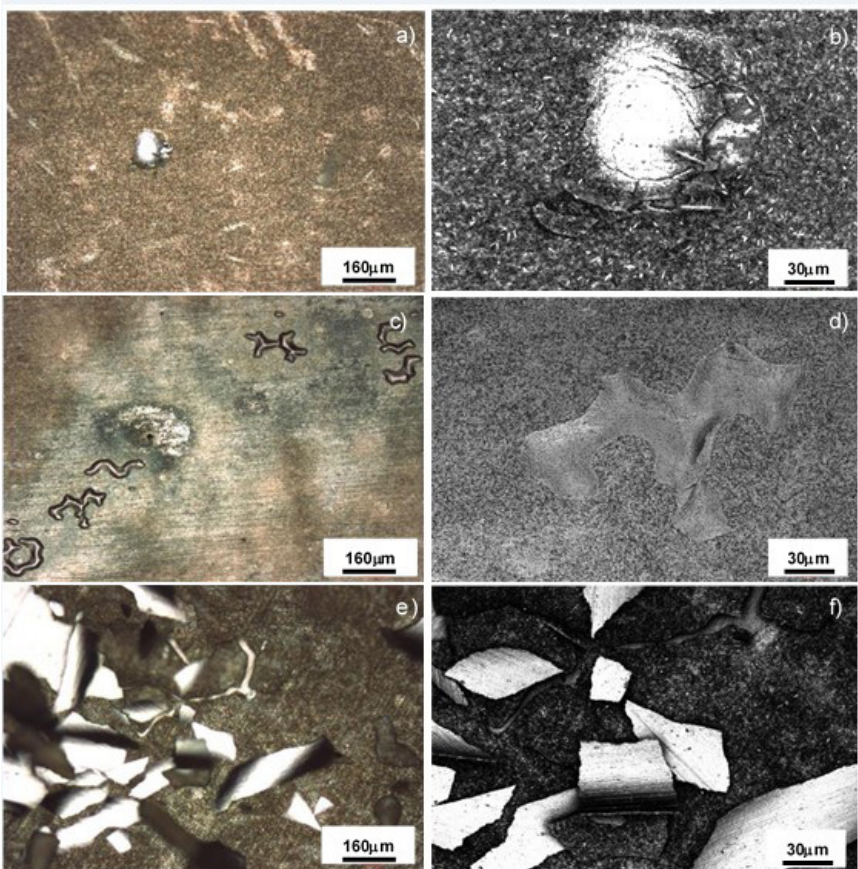
Figure 5. Optical (a, c, e) and laser scanning confocal microscope - LSCM (b, d, f) micrographs of several defects heterogeneously distributed on the oxide layer produced under O /steam/N atmosphere for each maraging 2 2 Table 5. Summary of the chemical composition determined by EDS measurements taken at different position indicated in Figure 8c. EDS quantitative analysis from points A, B, C and D (wt. %) Elem. Number